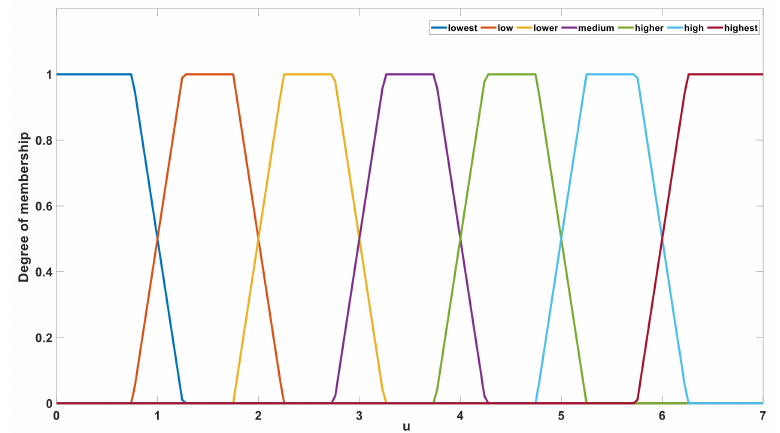
Figure 11. Membership function of the output variable u